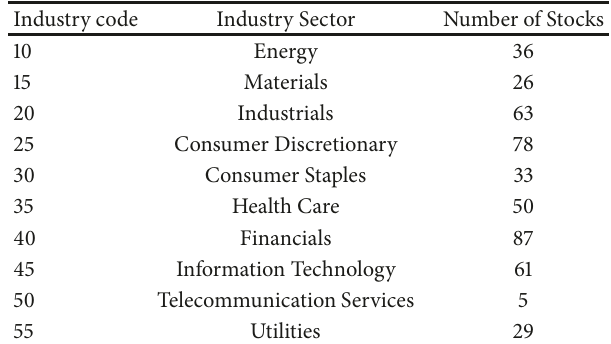
Table 2: 468 component stocks of S&P500 are included in the dataset. In this table, we list the Global Industry Classification Standard (GICS) code, sector name, and number of stocks for each industry sector in S&P500. All ten industry sectors are represented.